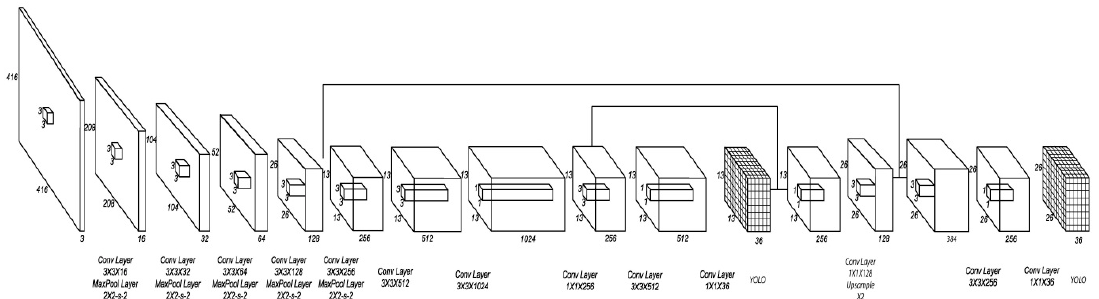
Figure 2. Convolutional neural networks (CNN) model’s architecture.